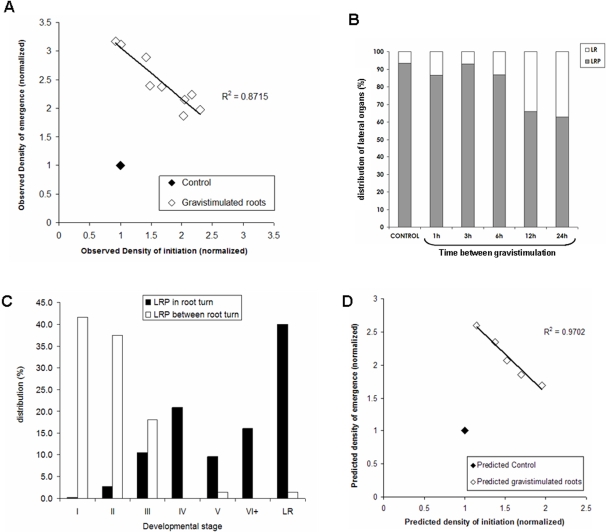
Gravistimulation enhanced balance between initiation and development.(A) Initiation density and emerged lateral root density were scored for plants gravistimulated according to the gravistimulation protocol presented in [15]. The results are given for primordia located in gravistimulated zones. Measurements were normalized in regard to the emergence density of non-gravistimulated plants. Each data point corresponds to a set of more than 20 seedlings. Non-gravistimulated Col-0 seedlings were used as a control group. (B) Emergence of lateral roots in gravistimulated roots. White bar: emerged lateral root percentage. Gray bar: non-emerged primordia percentage. Non gravistimulated Col-0 seedling were used as a control. (C) Distribution of primordia developmental stages for the 24 h time between gravistimulation treatment. White bar: primordia appearing and developing between gravistimulation (n = 72). Black bar: primordia appearing and developing in root turns (n = 373). (D) Initiation and emergence densities predicted by the mechanistic model with the added hypothesis of a drop of ET under gravistimulation.